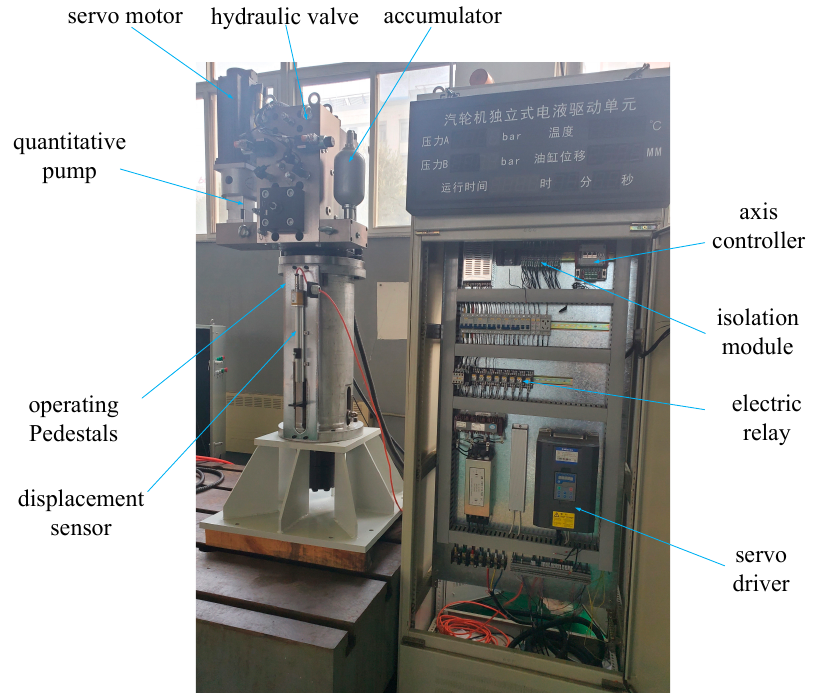
control seat. The electric control cabinet integrated the axis controller, the servo drive, and the isolation module.